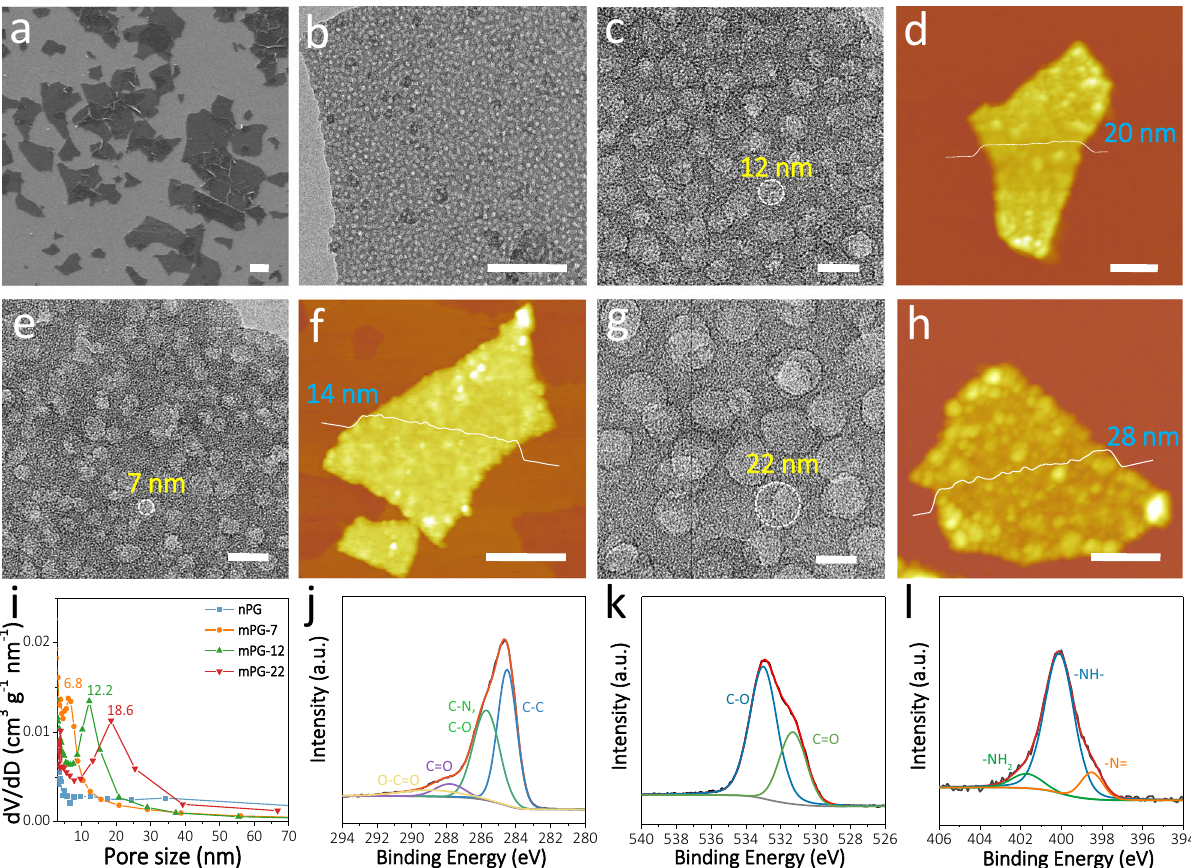
Fig. 2 Characterization of s-2D mPG heterostructures. a SEM image, b , c TEM and HRTEM images, d AFM image and corresponding thickness analysis of mPG-12 nanosheets. e HRTEM image, f AFM image and corresponding thickness analysis of mPG-7 nanosheets. g HRTEM image, h AFM image and corresponding thickness analysis of mPG-22 nanosheets. i The pore size distribution curves of mPG-7, mPG-12, mPG-22, and nPG nanosheets. j – l High- resolution XPS ( j ) C 1 s , ( k ) O 1 s , and ( l ) N 1 s spectra of mPG-12 nanosheets. Scale bars: a 1 μ m, b 200 nm, c , e , g 20 nm, and d , f , h 500